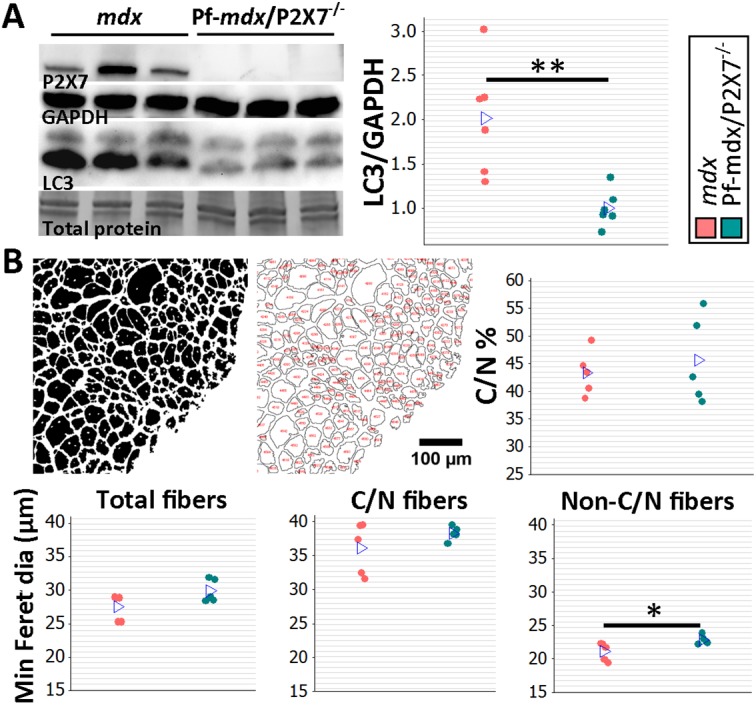

P2RX7 ablation reduces the pathology in 20-mo-old tibialis anterior muscles.(A) Representative Western blots (left) confirming P2RX7 protein expression in 20-mo-old TA and illustrating decreased autophagy (LC3I to LC3II shift), with the results in the graph showing lower levels of LC3II relative to GAPDH in TA from 20-mo-old Pf-mdx/P2X7−/− compared to mdx mice (t-test, t = 3.74, df = 10, p = 0.004). Total protein staining is shown to illustrate the equal protein loading. (B) Representative ImageJ output masks from morphometric analyses of TA fibers (left) and graphs showing representative results (right and bottom). While no differences were found in the proportion of C/N fibers or the average minimum Feret diameter of total or C/N fibers (t-test, t = 0.57, df = 8, p = 0.586; t = 2.04, df = 8, p = 0.076; t = 1.25, df = 8, p = 0.248, respectively), there was a significant increase in the minimum Feret diameter of non-C/N fibers in mdx/P2X7−/− compared to mdx muscles (t-test, t = 2.58, df = 8, p = 0.032). *p < 0.05, **p < 0.005.